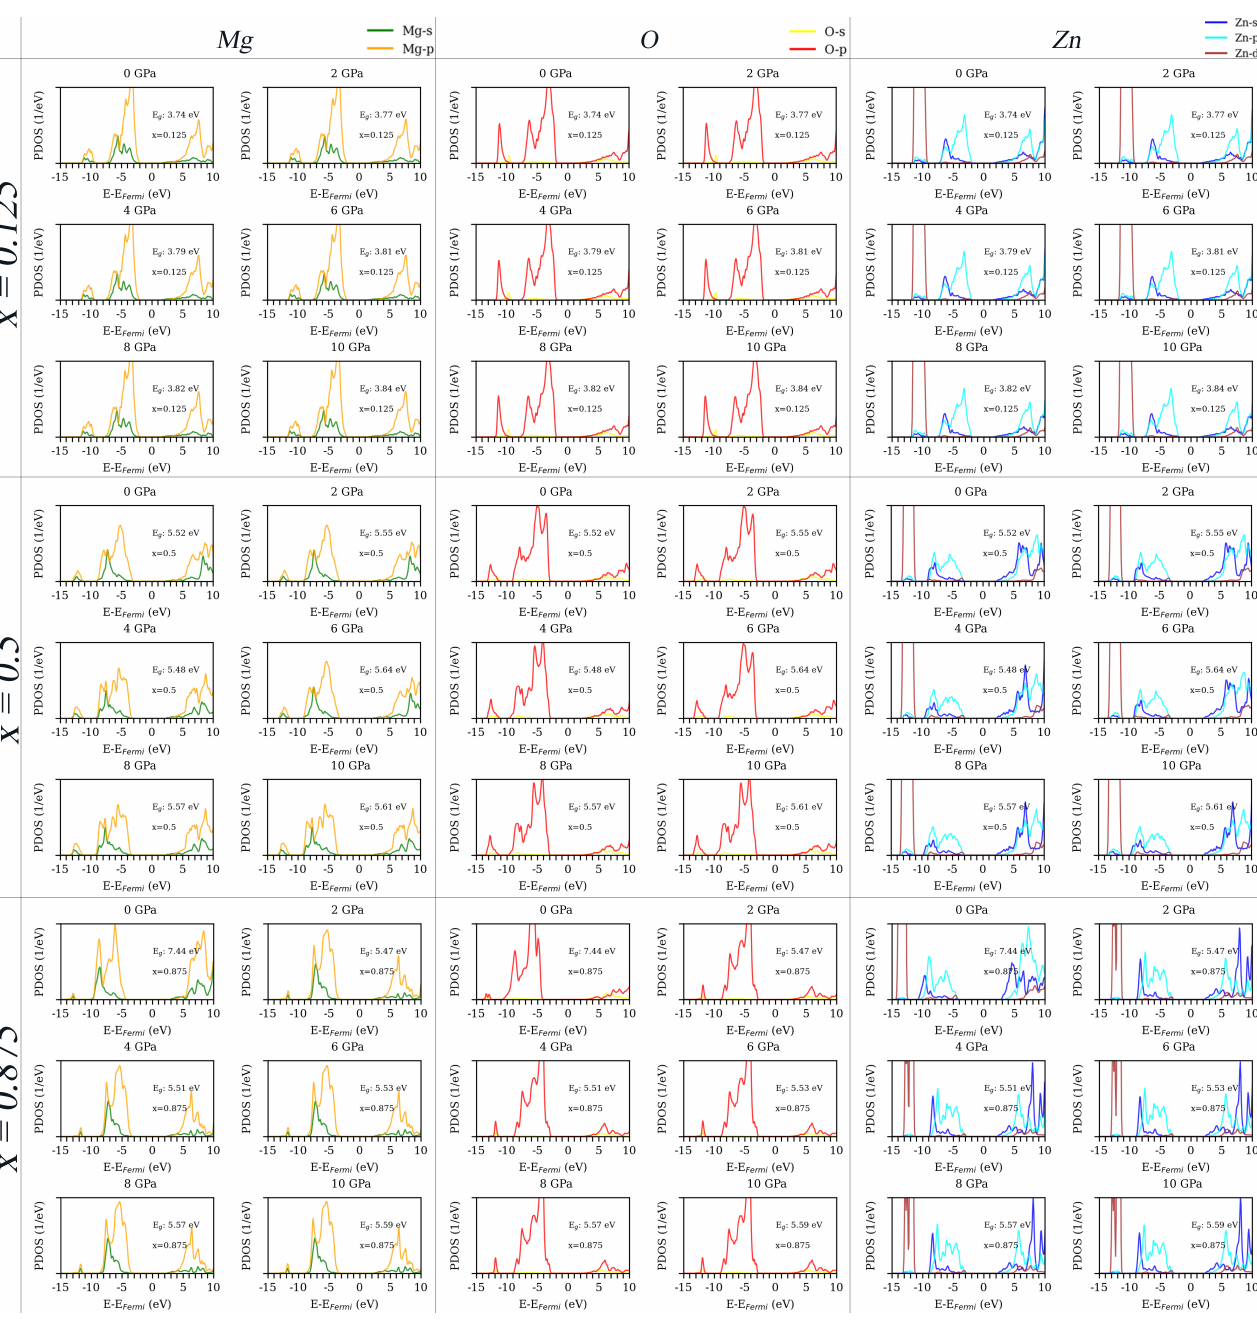
Figure A3. Partial density of states (PDOS) of wurtzite (WZ) Zn 1 − x Mg x O for WZ ZMO2 models at different concentration (x = 0.125, 0.5 and 0.875) with the pressure from 0 to 10 GPa in 2 GPa increments, which correspond to Figure